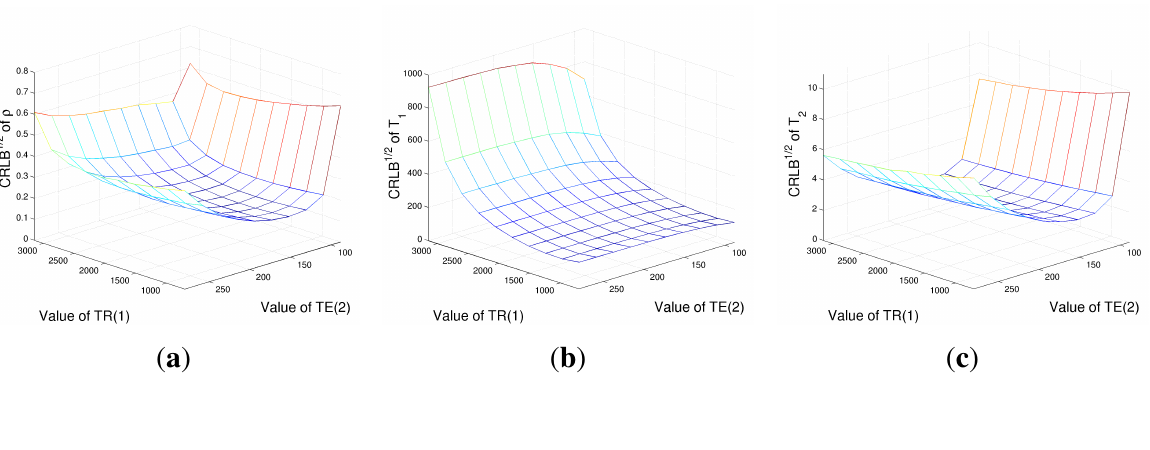
Figure 4. The square root of the CRLB of proton density ρ ( a ), T T relaxation time ( c ) for different combinations of T 2 T = 1 , 800 ms and T 1